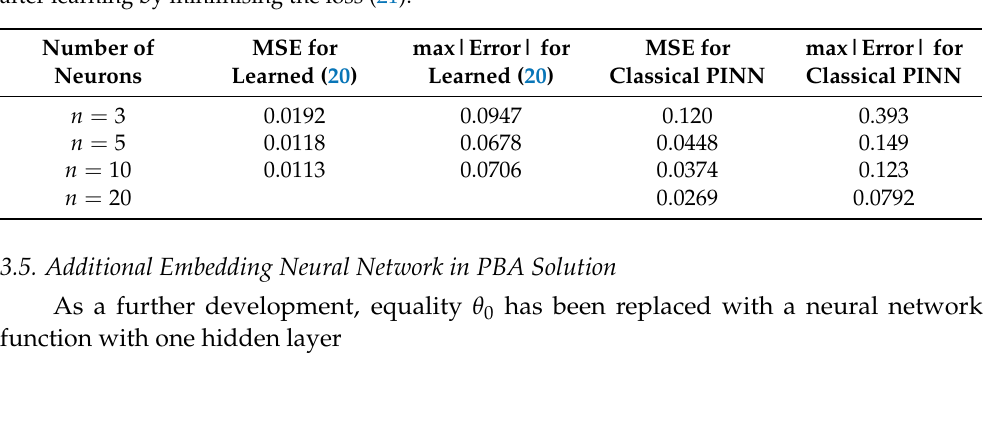
Table 2. Results of PBA-PINN learning. A comparison of the mean square error (MSE) and the maximum value of the absolute error for PBA-PINN (20) with n neurons per a hidden layer in an embedded network and classical PINN with n neurons of a hidden layer and activation function (18) after learning by minimising the loss